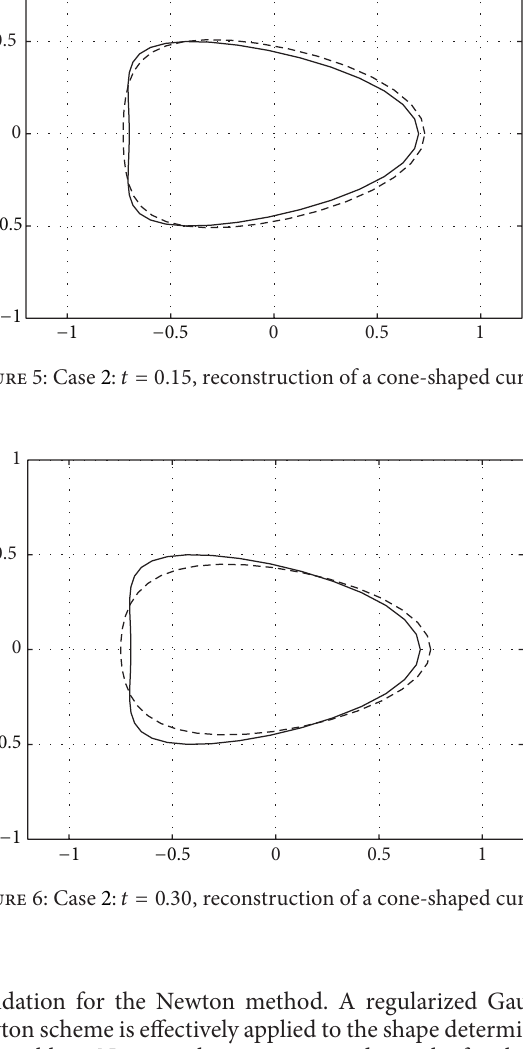
Figure 3: Case 1: 𝑡 = 0.20 , reconstruction of an elliptic curve.